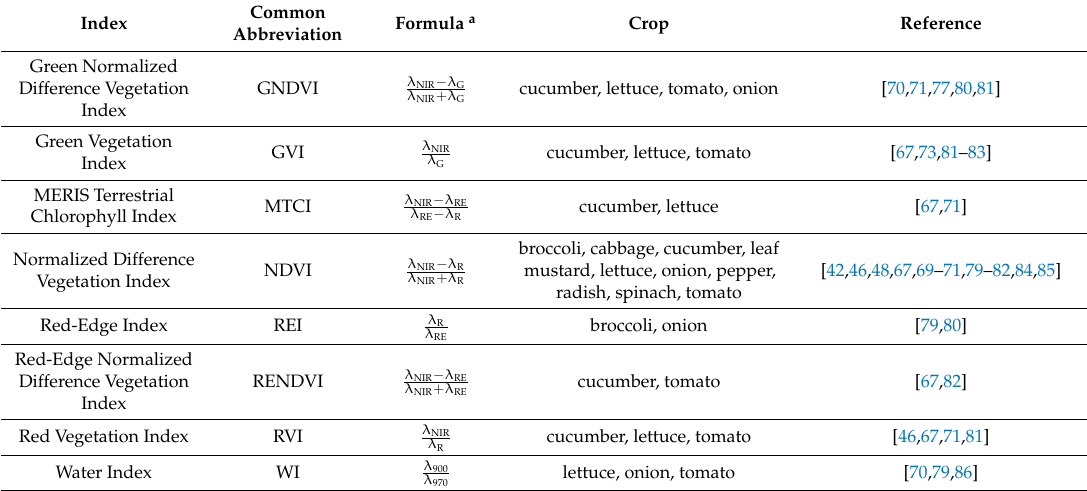
Table 1. Examples of the most common vegetation indices potentially available for phenotyping studies in vegetable